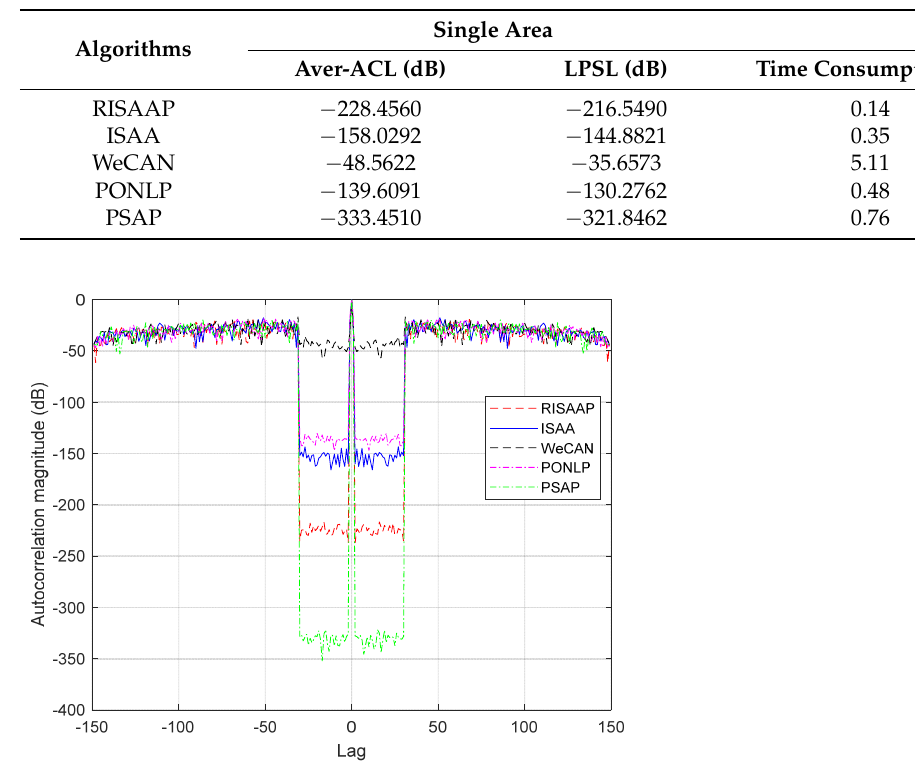
Table 1. Performance comparison for suppressing single area sidelobes of different algorithms.